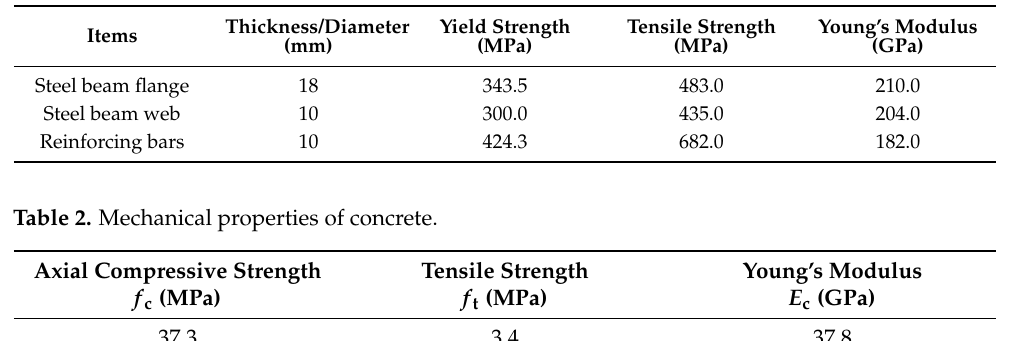
Figure 2. Dimensions and reinforcement details: ( a ) elevation view; ( b ) side view. Table 1. Mechanical properties of steel.